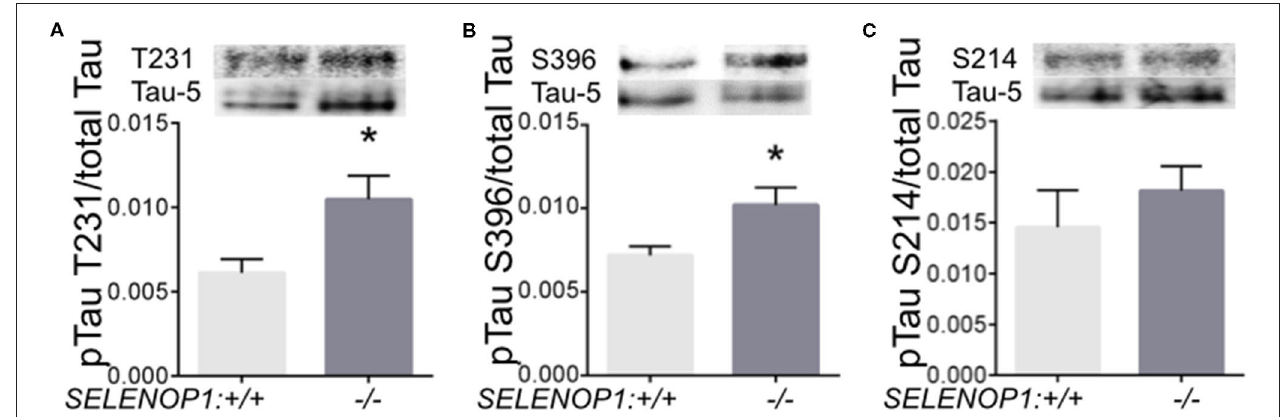
FIGURE 6 | Deletion of SELENOP1 increases tau phosphorylation in mouse hippocampus. Western blots of phospho-specific tau antibodies relative to the Tau-5 antibody, which recognizes total tau. Blot images are superimposed above graphs. (A) SELENOP1 deletion resulted in increased tau phosphorylation at threonine 231. (B) Serine 396 was also significantly reduced in SELENOP1 knockouts. (C) No change in phosphorylation at serine 214. N = 4 animals/group. Statistical analysis is performed by Student’s unpaired t -test, * p <